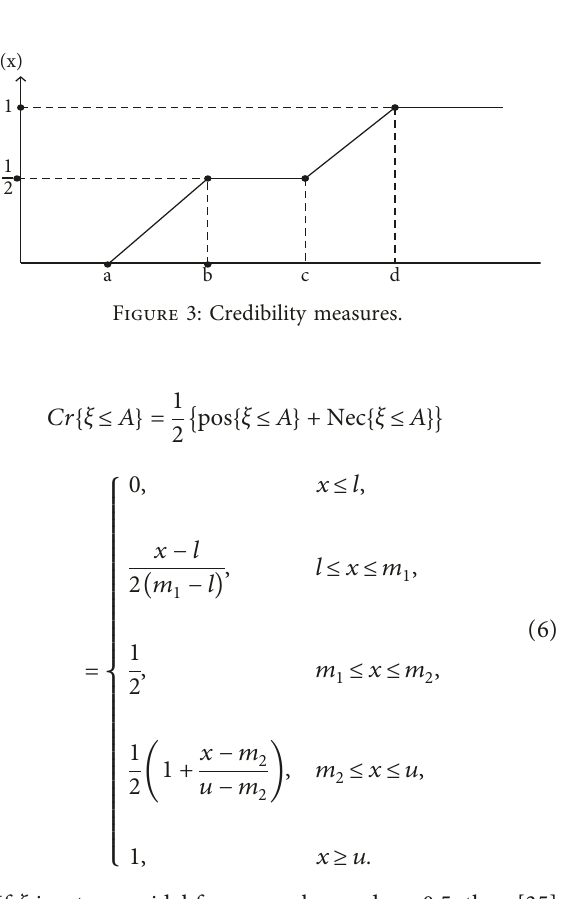
Figure 2: Possibility and necessity measures. (a) (Pos) and (b) (Nec).